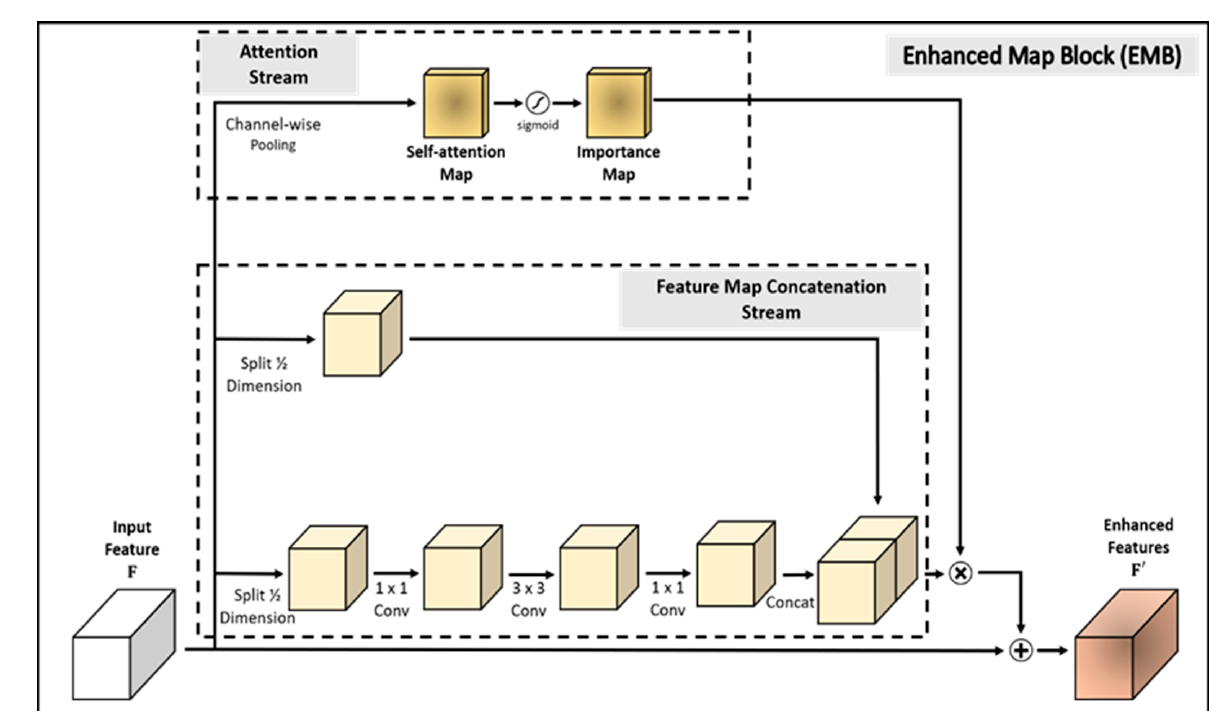
Figure 2. EMB block diagram. The self-attention map is produced by channel-wise average pooling on the input feature map generated by convolutional layers. Based on the self-attention map, we generate the importance map using a sigmoid activation function. The concatenation stream splits the feature map in half, performs three convolution operations on one of the half maps, and concatenates it with the other half.